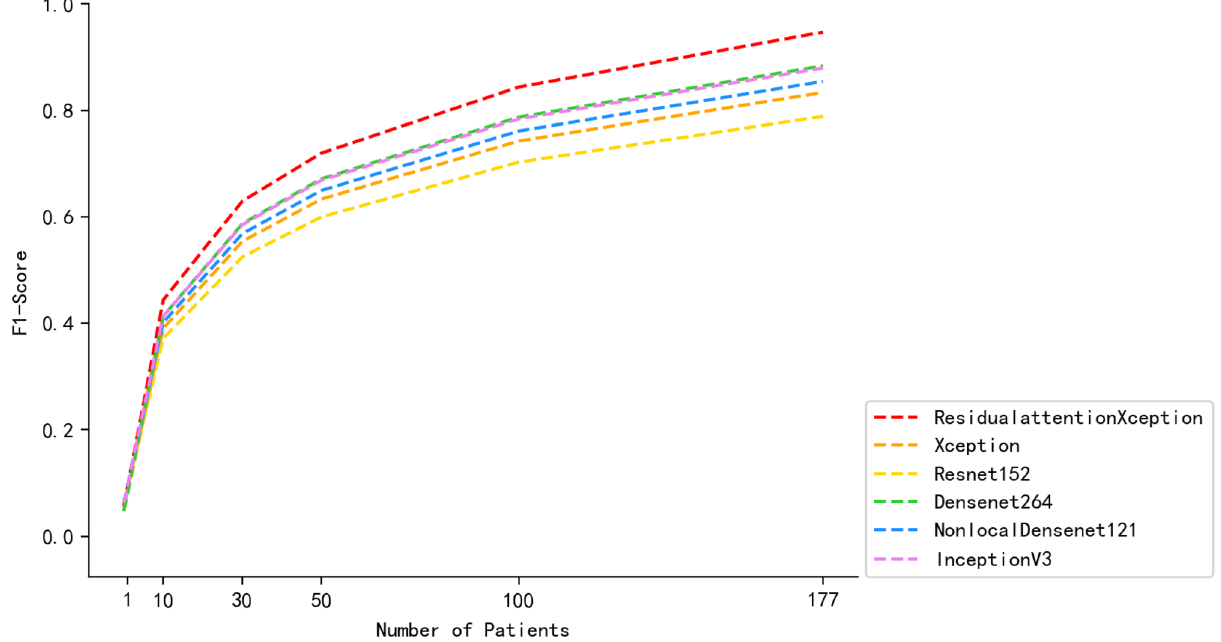
Figure 9. A graph of how the performance of the model varies with the number of medical records.